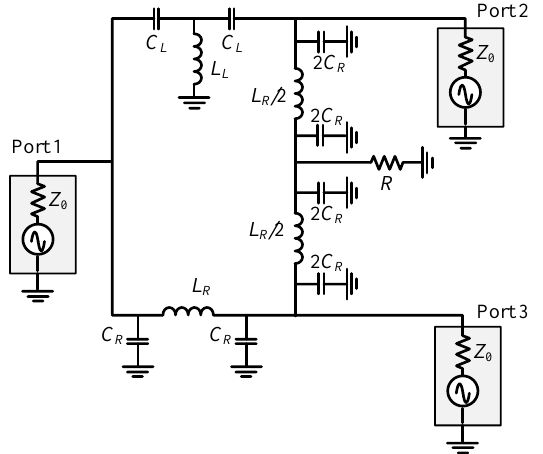
circuit is shown in Figure 5.